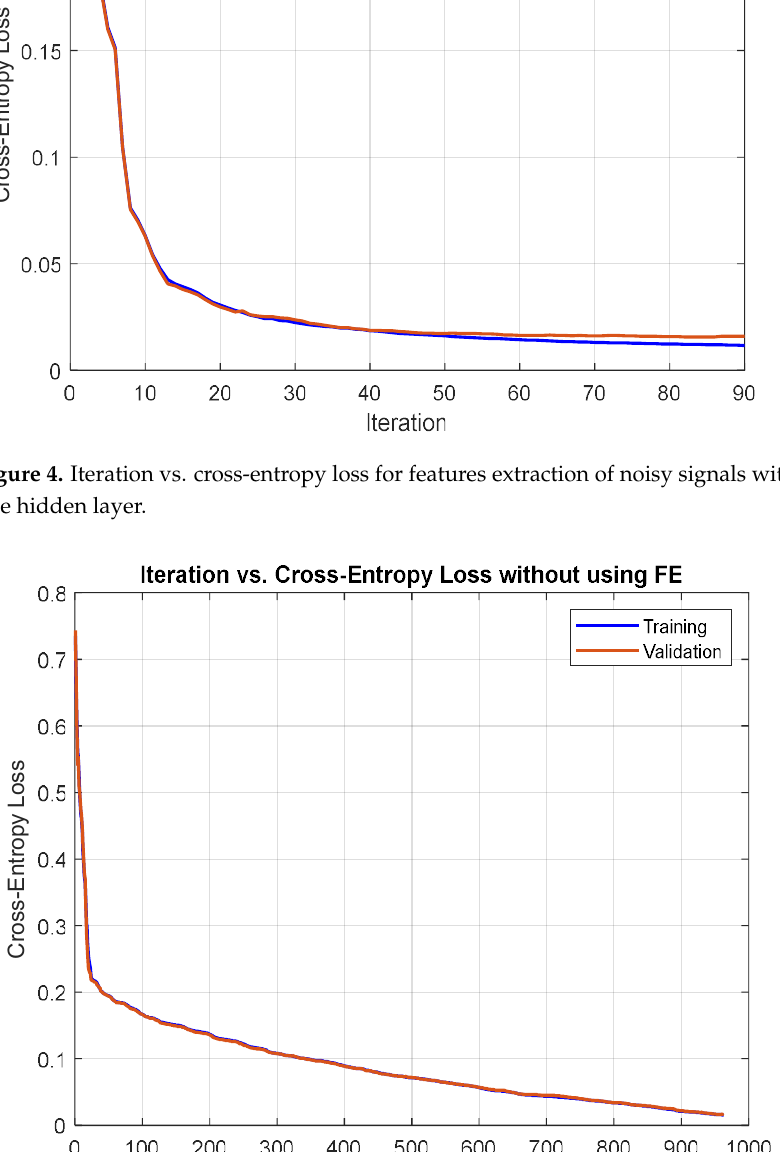
Figure 5. Iteration vs. cross-entropy loss for noisy signals with length 6400 and three hidden layers with (30, 25, and 20) nodes. Note that increased layers and nodes lead to increased accuracy of 96 and more iterations of 963.